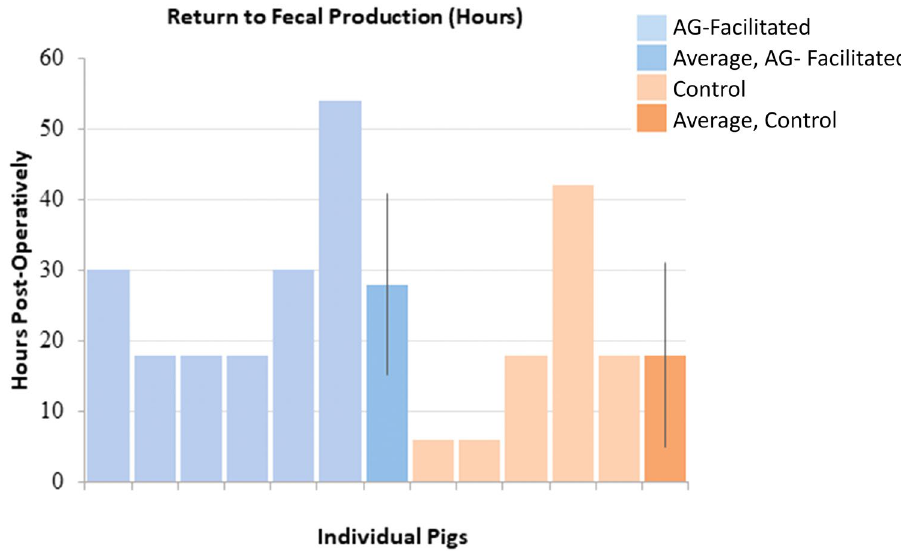
Figure 8. Hours post-operatively that individual pigs returned to fecal production. Black bars represent standard deviations of the averages for each group.